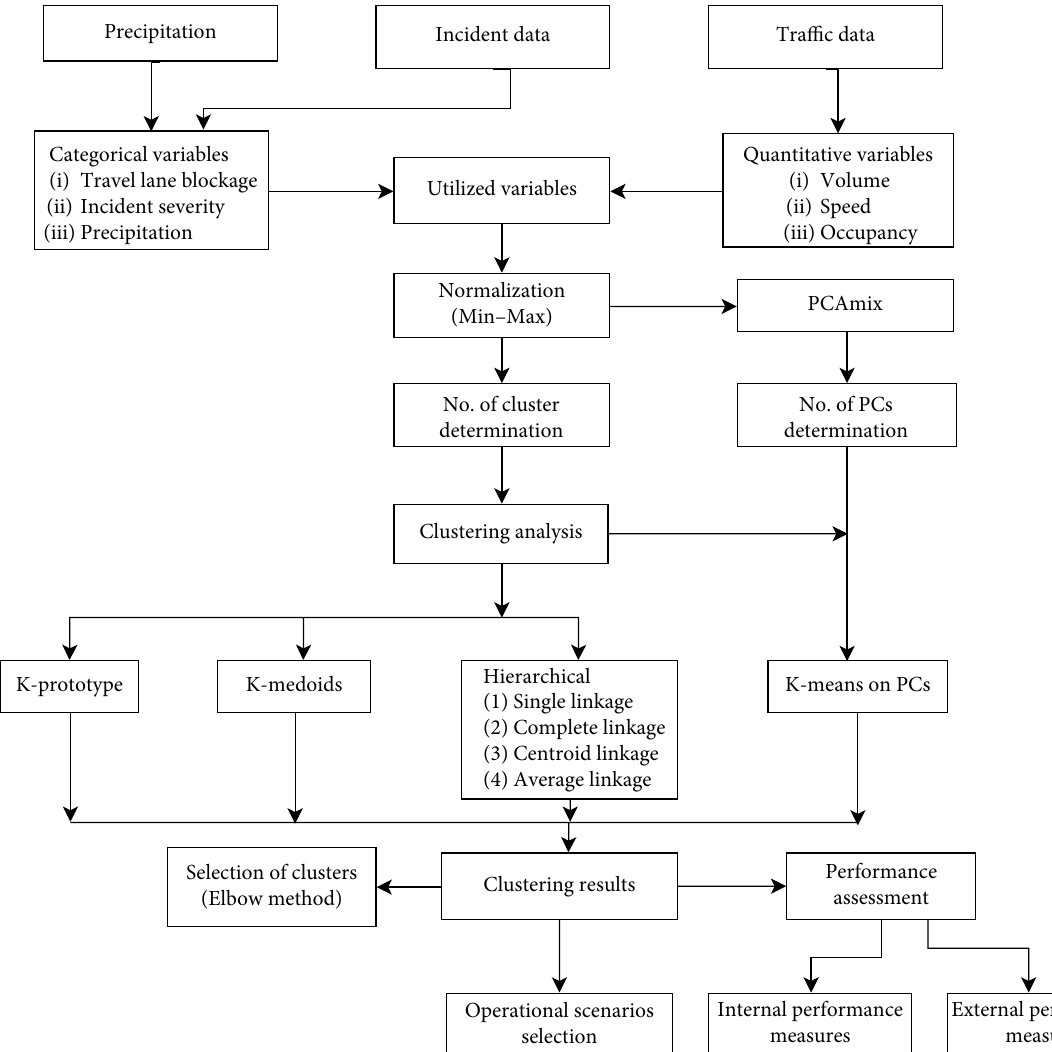
Figure 2: Flow chart of the analysis